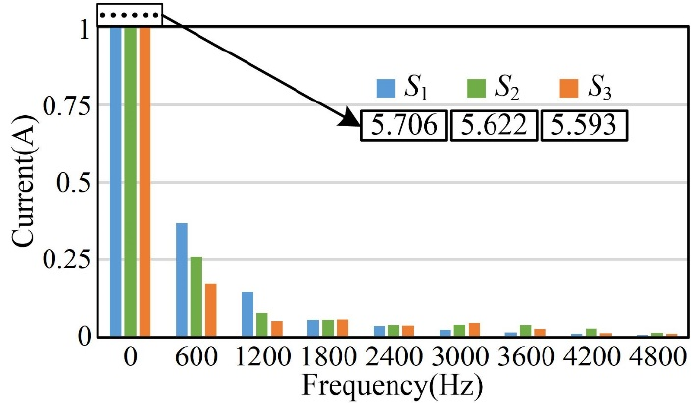
Figure 14. Equivalent current spectrum diagram of S 1 , S 2 and S 3 under condition 1.